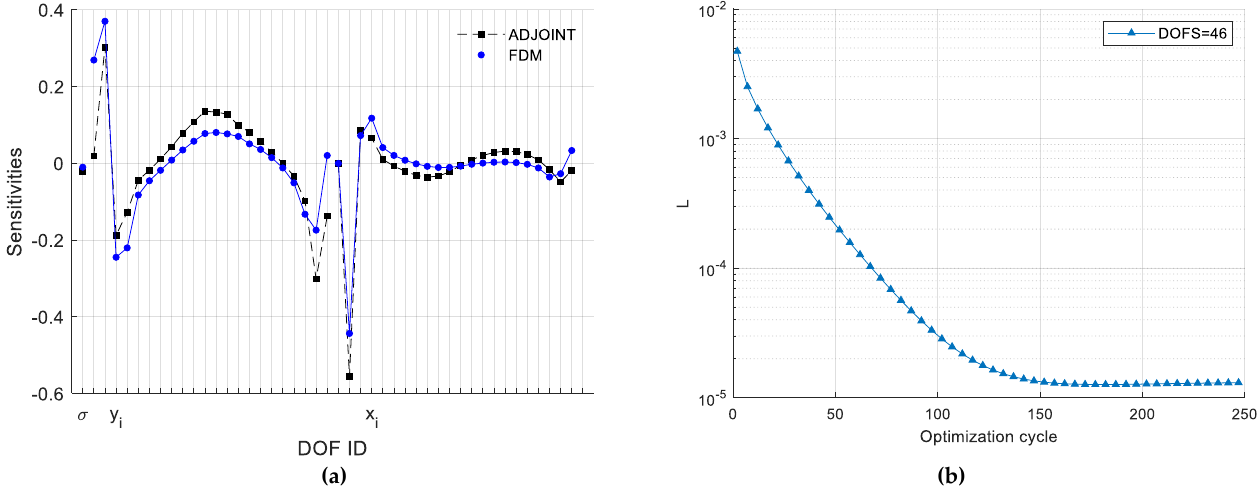
Figure 5. Present method for NACA16–006 at a = 4 ◦ for N = 46 DOFS. ( a ) Comparison between the sensitivities obtained using the proposed method and FDM. ( b ) Cost functional evolution as the optimization cycles progress.